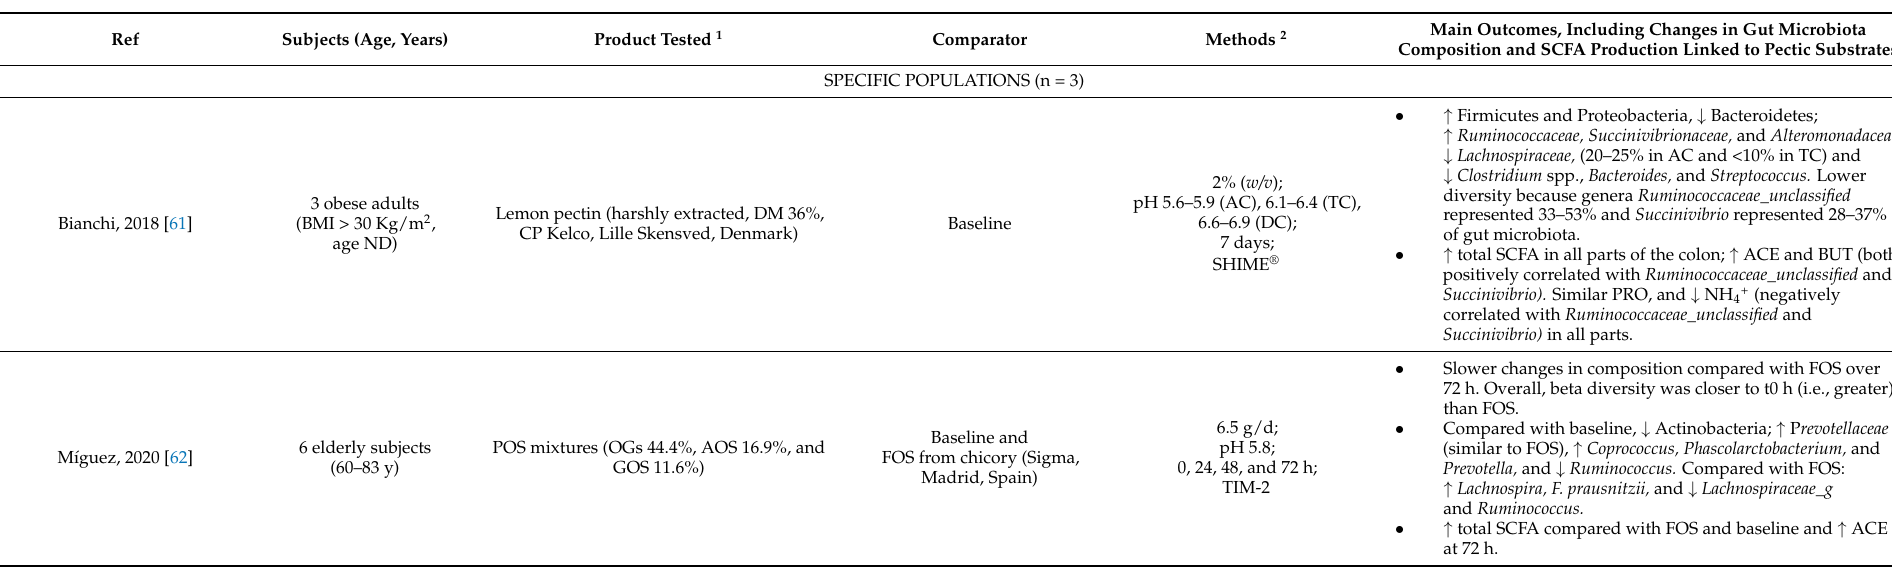
Legend: Upward arrows indicate an increased bacterial abundance, and downward arrows indicate a decreased bacterial abundance. 1 Test product were described as in the studies, and they were produced under laboratory conditions when no supplier was mentioned. 2 All studies used a non-targeted bacterial group determination approach within their